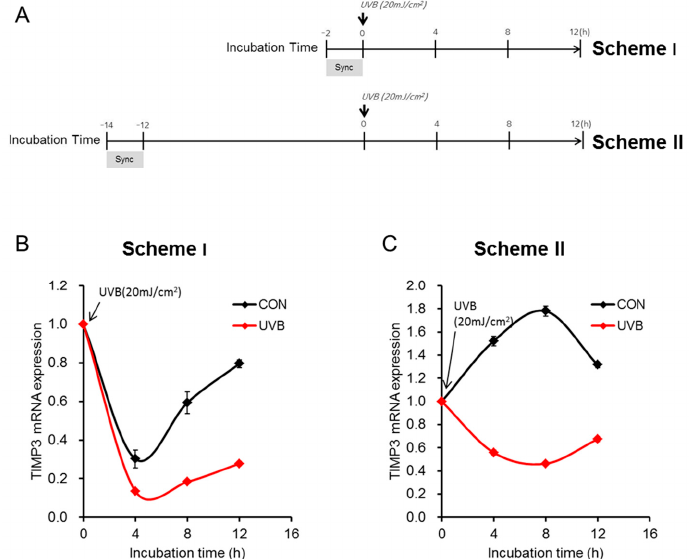
Figure 3. Schemes regarding the effects of UVB irradiation on TIMP3 expression depending on treatment. ( A ) Schemes for irradiation. After synchronization (Sync) of NHEKs by being